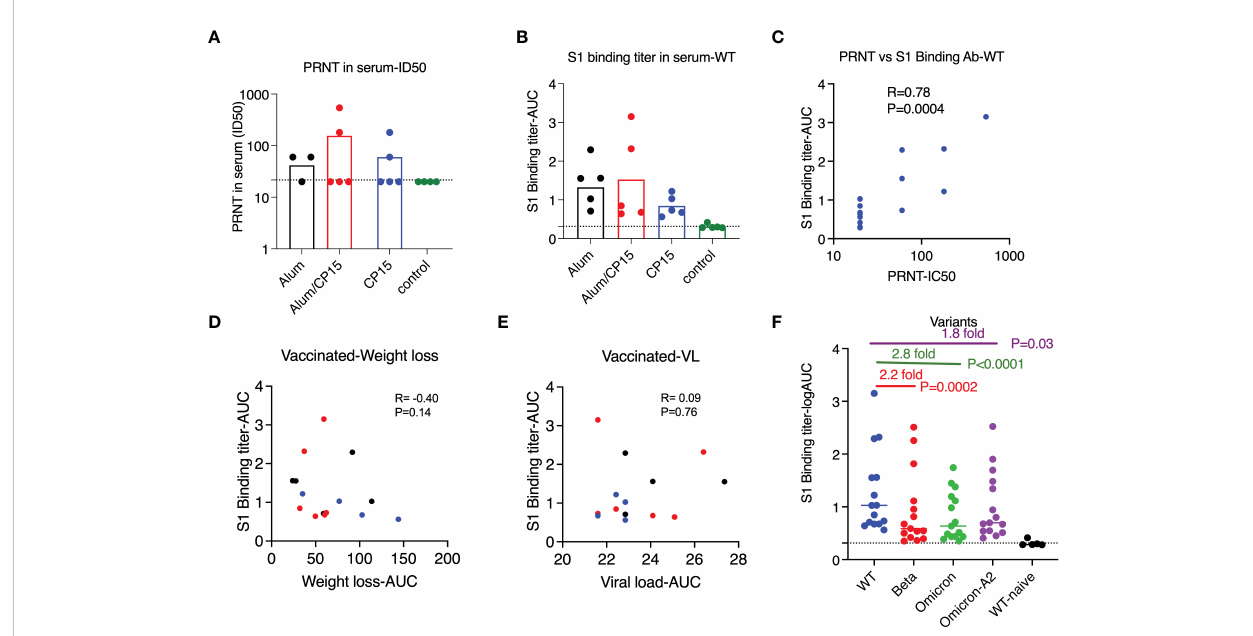
FIGURE 5 Vaccine-induced humoral immunity did not correlate with protection after challenge with SARS-CoV-2 WA strain in Syrian golden hamsters. (A, B) . PRNT titers (A) and S1-speci fi c binding antibody titers (B) against SARS-CoV-2 WA/Wuhan strain in the serum of the vaccinated and naïve animals (4 weeks after the second vaccination). (C) S1-speci fi c binding antibody correlated with PRNT titers. (D, E) . S1-speci fi c binding antibody titers did not correlate with weight loss (D) or viral load reduction (E) of the vaccinated animals. Spearman analyses were used for the correlations. (F) . S1-speci fi c binding antibody titers against S1 of SARS-CoV-2 wild type (Wuhan) strain, beta, Omicron, and Omicron A.2 variants. Each symbol represents one animal. Non-parametric one-way ANOVA analyses with Dunn ’ s multiple comparison correction was used to compare the titers against wild type and the variants. Dashed line shows the titers of the naïve animals. Means ± SEM are